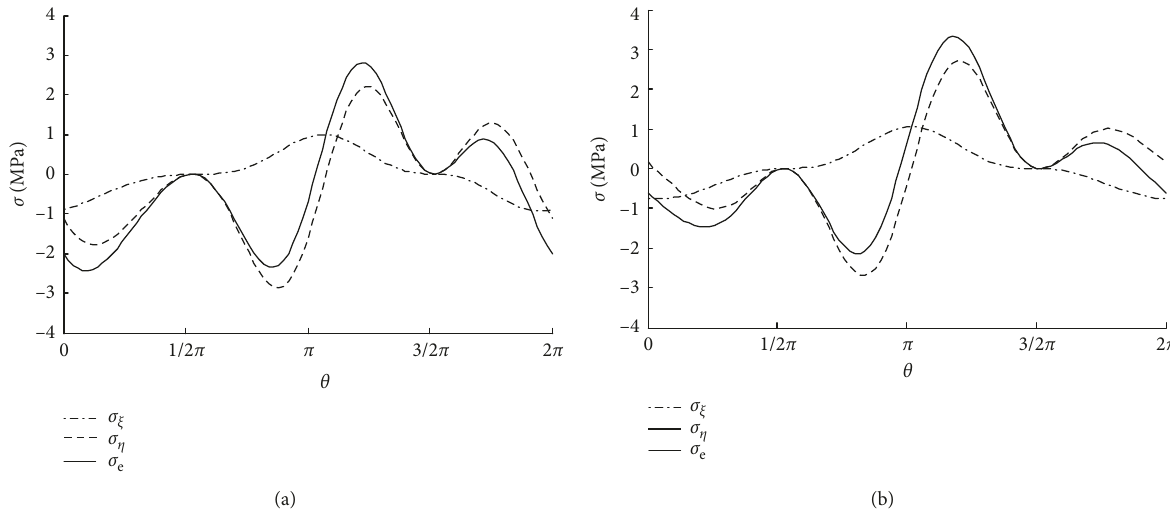
Figure 17: Stress variation during a rotation period with Ω � 7000rpm, r � 0 . 4, ε � 1 × 10 − 5 m, and ζ � 0.01: (a) β � 3/4 π ; (b) β �